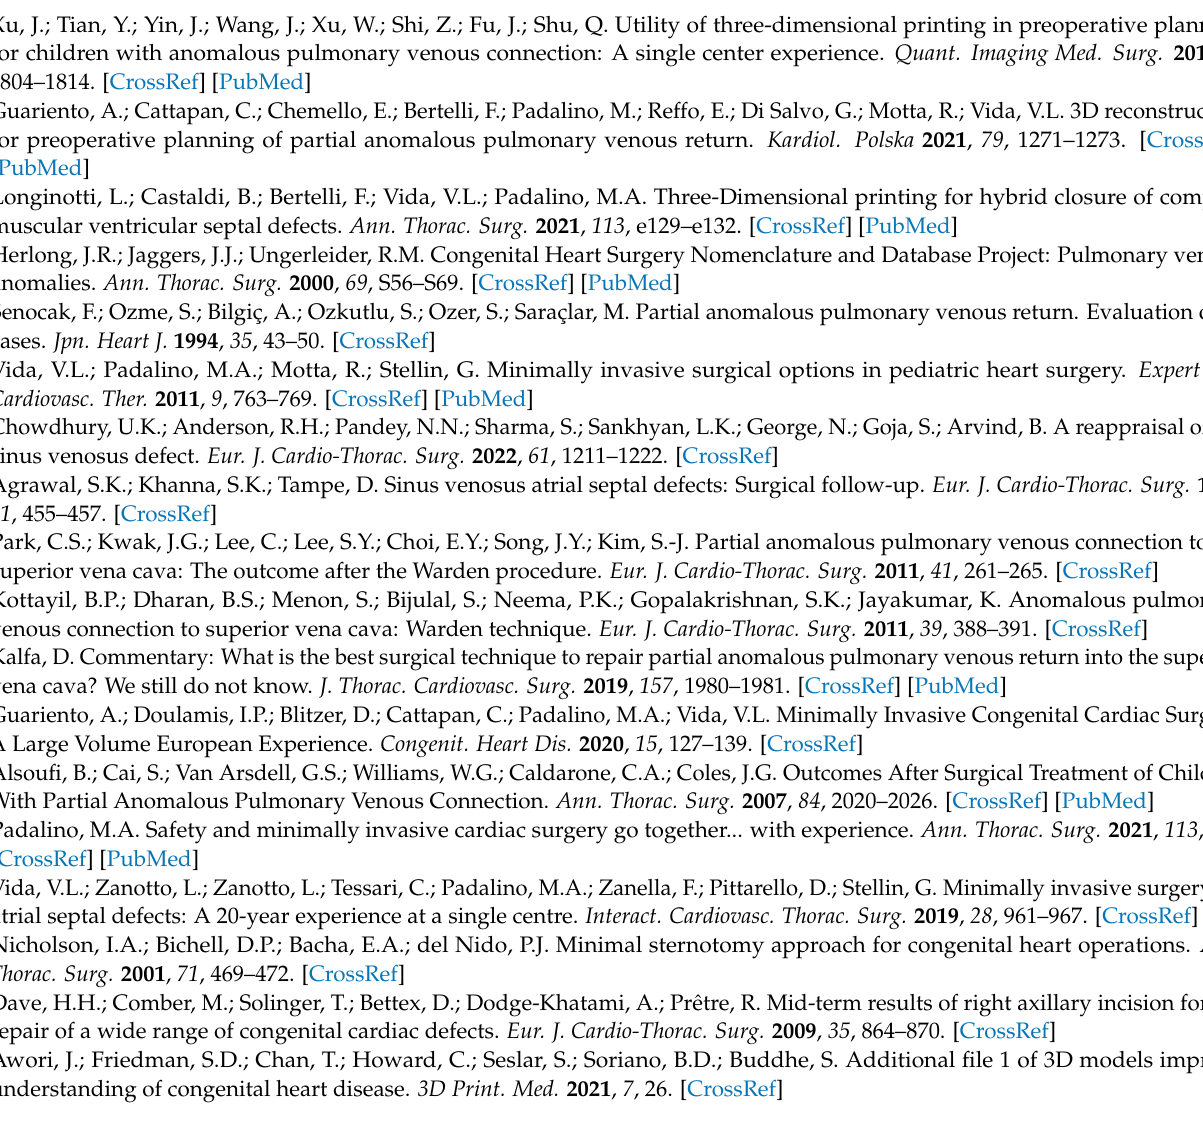
patient results; Table S2: Patients’ specific ratio value; Video S1: Right lateral minithoracotomy approach to partial anomalous pulmonary venous